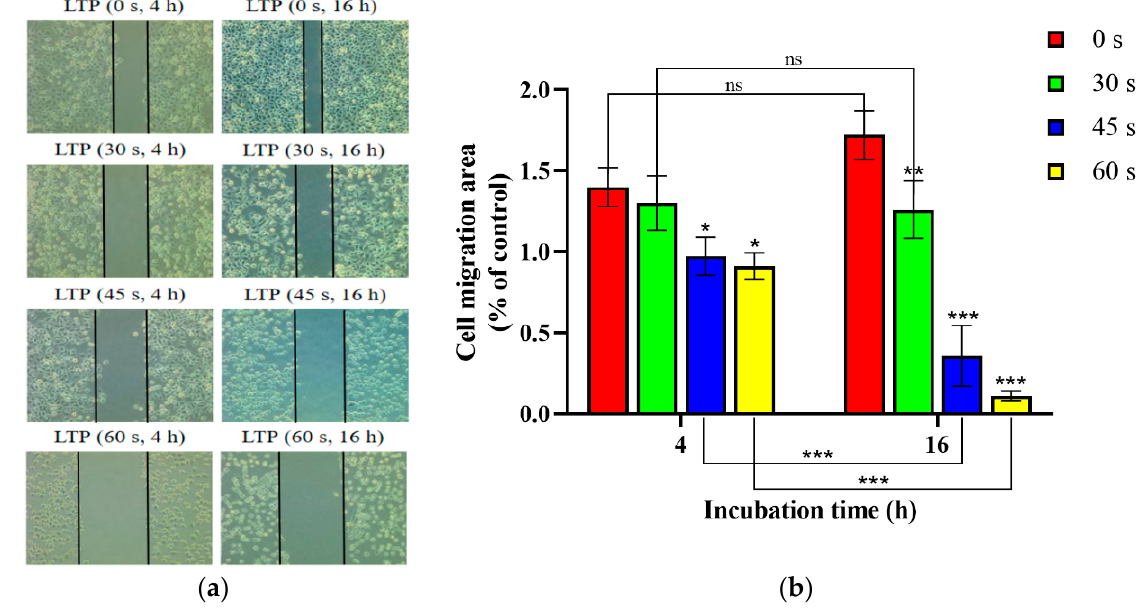
Figure 6. LTP affects the cell migration. ( a ) The relative ratio was calculated as the ratio between the experimental groups and the 0 s LTP treatment groups of CALU-1 cells at 0, 30, 45, and 60 s, with 4 and 16 h thermostatic incubation. ( b ) The data were quantitated and graphed. * p < 0.05; ** p < 0.01; *** p < 0.001; compared with the 0 s LTP treatment group.